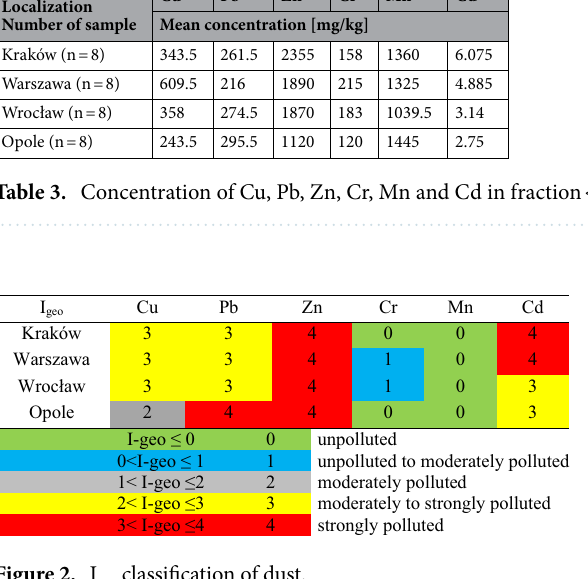
Figure 2. I geo classification of